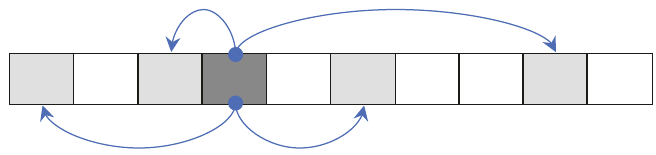
Figure 1: Randomly assigned relations between routines (N = 10, K = 4).